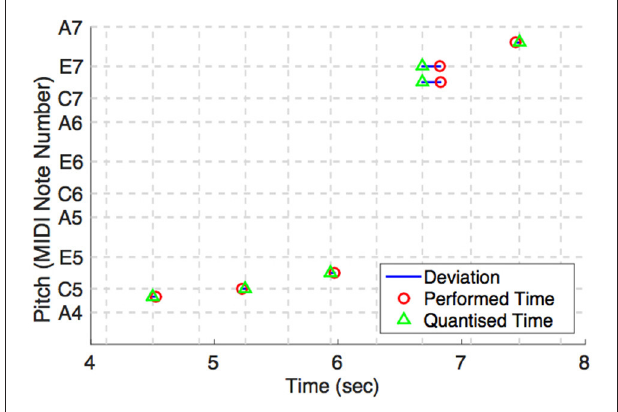
FIGURE 3 | Metrical deviations as a behavioral measure of IPS. Horizontal dashed lines indicate the MIDI note numbers of important pitches in A Aeolian. Vertical dashed lines indicate eighth-note beats. On the eighth-note beat before 7 s, there is a relatively large timing deviation between the participant’s and therapist’s playing. It can be seen that the participant’s performed time of two notes (red circles) lags behind that of the therapist’s (green triangles). The blue lines are a visual aid to indicate the deviation from the closest eighth-note beat.